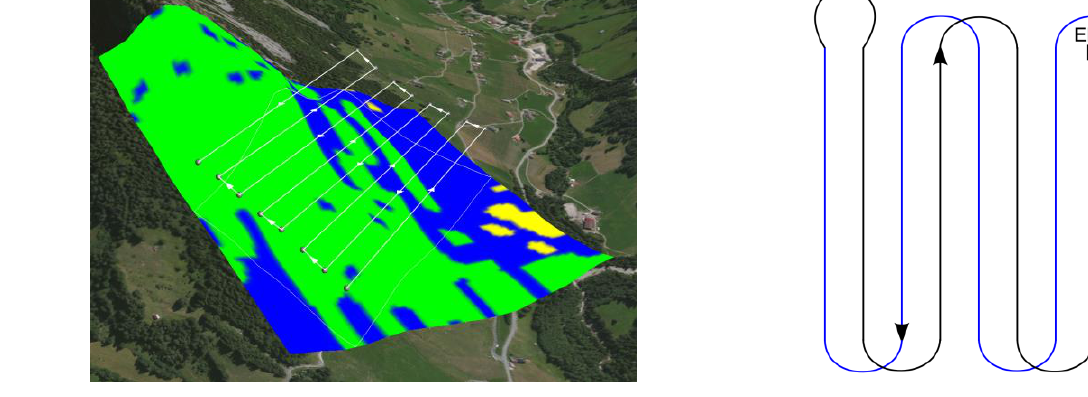
Figure 2: Analysis of the digital terrain model; slope analysis Figure 3: Alternative flying